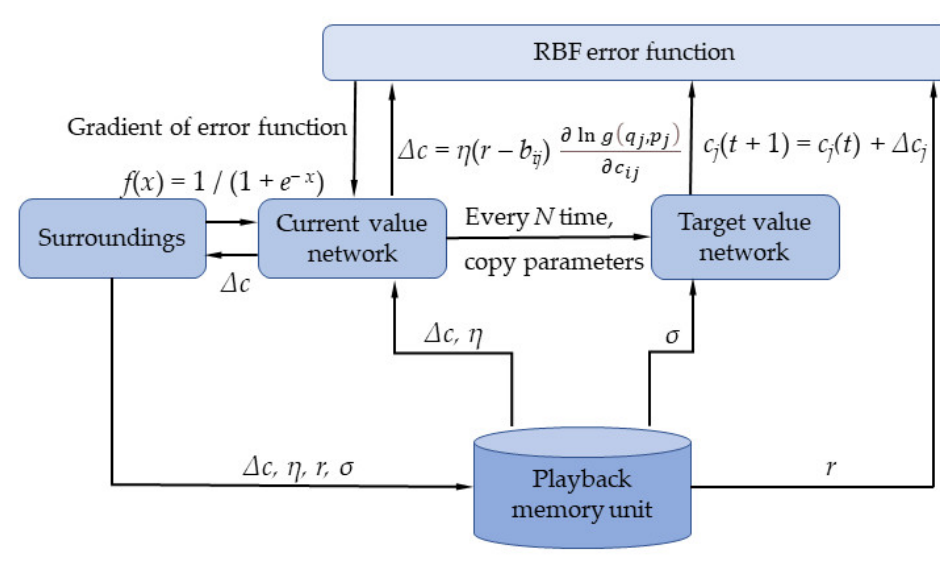
Figure 1. Algorithm training flowchart.